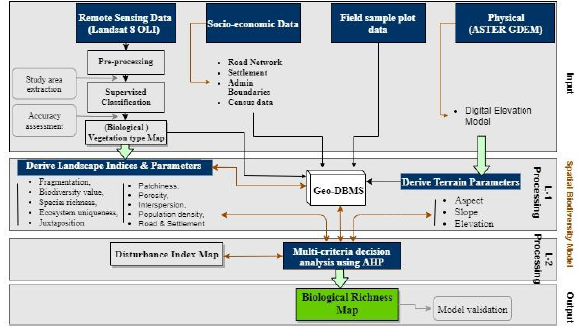
Figure 2. The flowchart to characterized biological